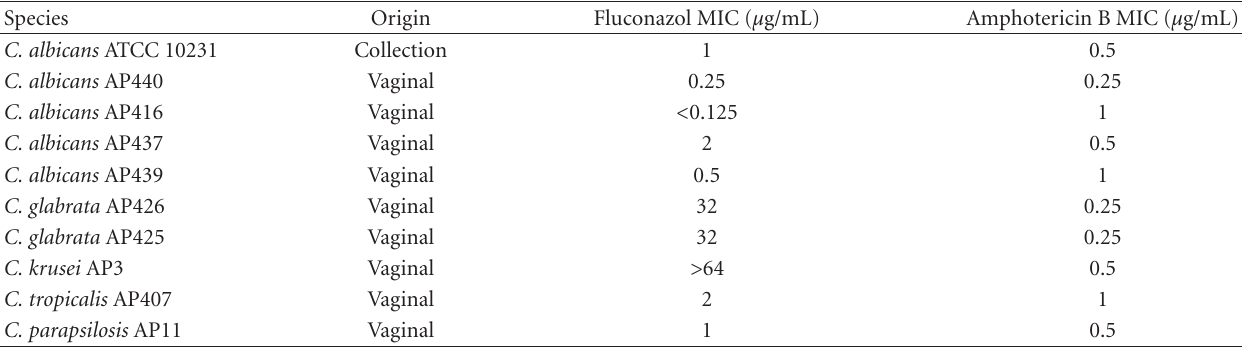
Table 1: Candida spp. origin and susceptible profile to classic antifungals, namely, fluconazole and amphotericin B. Minimal inhibitory concentrations (MICS) are presented in µ g/mL.